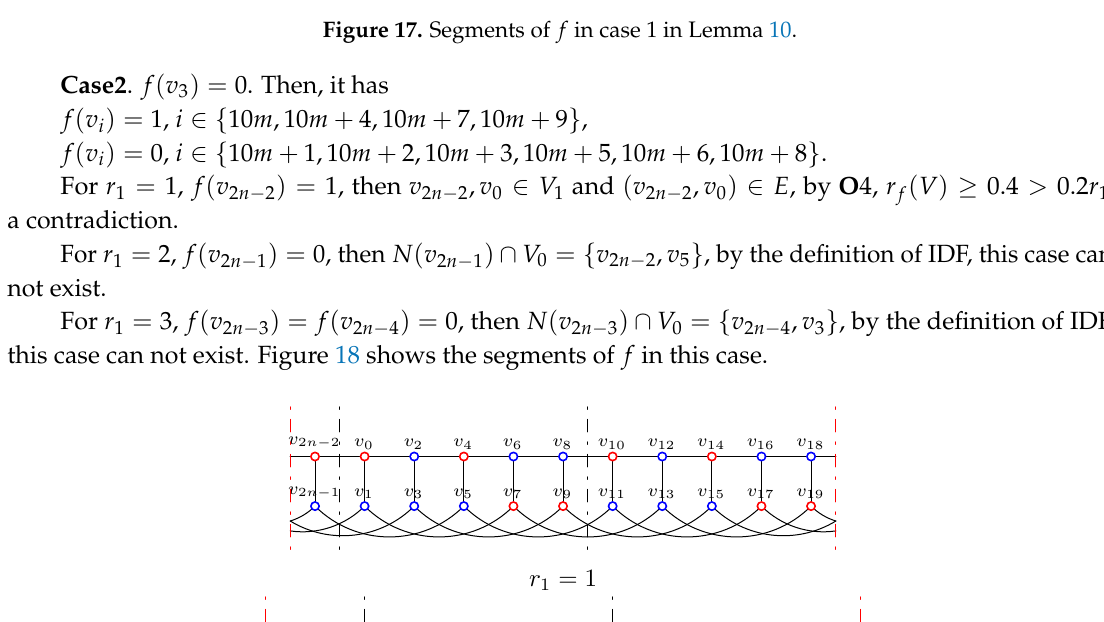
Figure 18. Segments of f in Case 2 in Lemma 10.